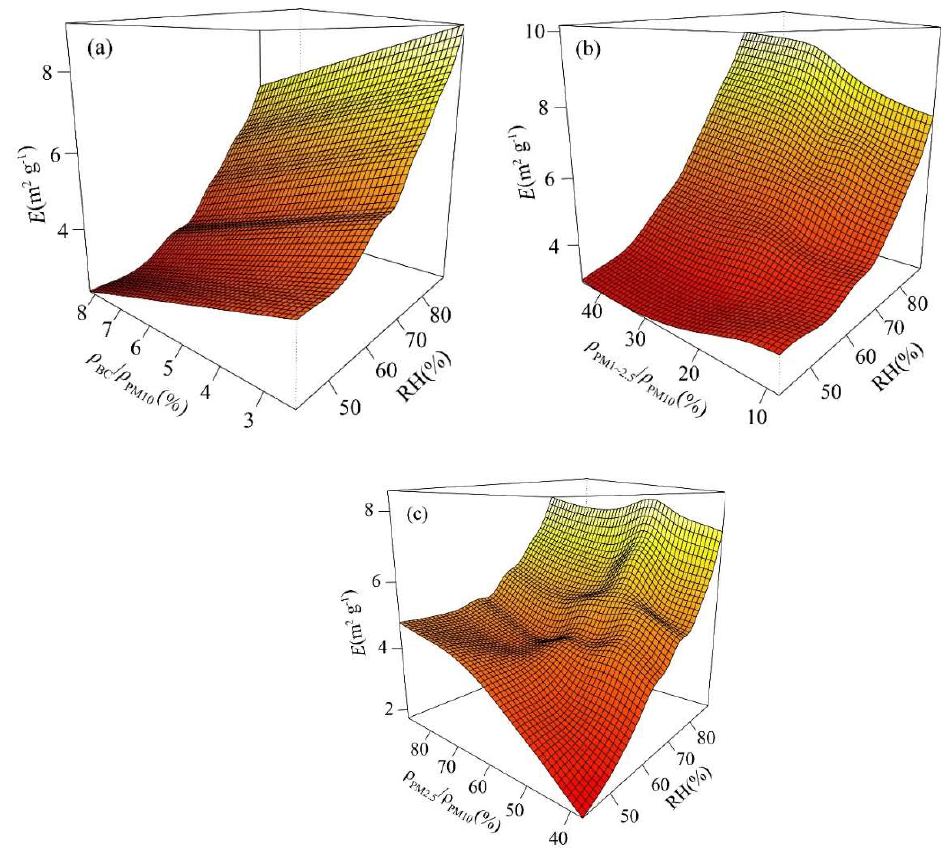
Figure 10. At PM 2.5 pollution concentration, three-dimensional graphs for the influence of the interaction between the RH and aerosol components on the change of aerosol extinction coefficient per unit of mass. ( a – c ) represent the RH- ρ BC / ρ PM10 , RH- ρ PM1~2.5 / ρ PM2.5 and RH- ρ PM2.5 / ρ PM10 ,